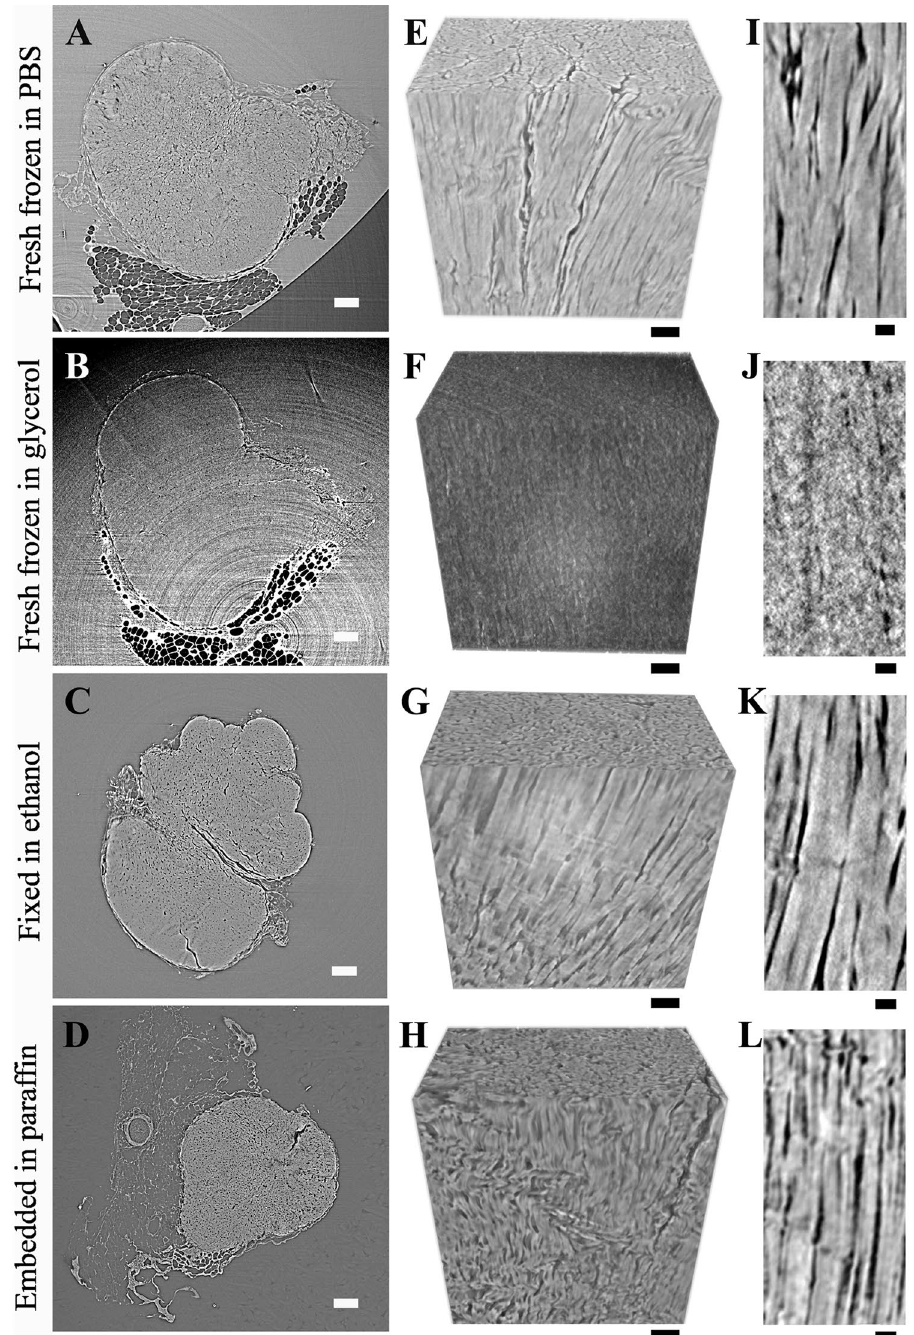
Figure 4. Sample preparation can affect the visibility of the internal structures. ( A – D ) Cross sections of the central region of the tendon for: ( A ) fresh frozen sample imaged in PBS, ( B ) fresh frozen sample in glycerol, ( C ) fixed tendon imaged in ethanol, ( D ) paraffin embedded sample. ( E – H ) 3D renderings of fibers in the central region of the respective tendons to the left, ( I – L ) longitudinal slice showing few fibers at high magnification. The darker region between fibers is the tendon non-collagenous matrix. All samples were imaged with HNAM. Scale bars: ( A – D ) 150 µm, ( E – H ) 50 µm, ( I – L ) 25